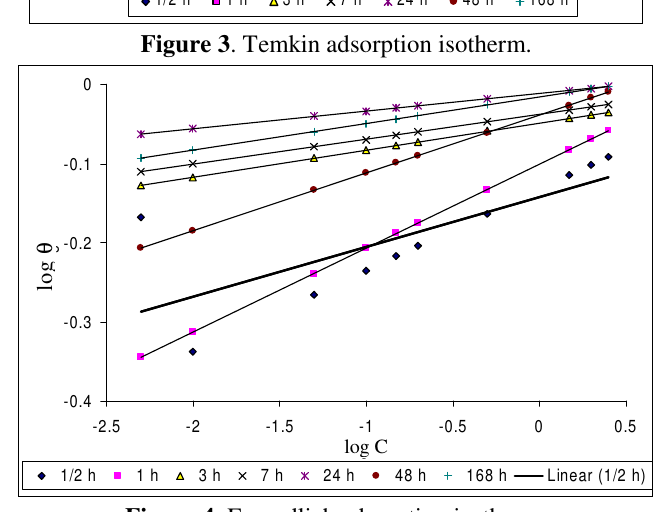
Figure 4 ..Freundlich adsorption isotherm.